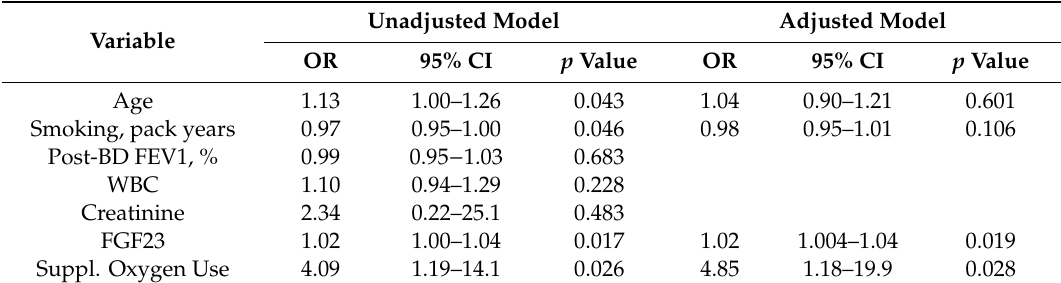
Table 3. Associations with the frequent exacerbator phenotype.